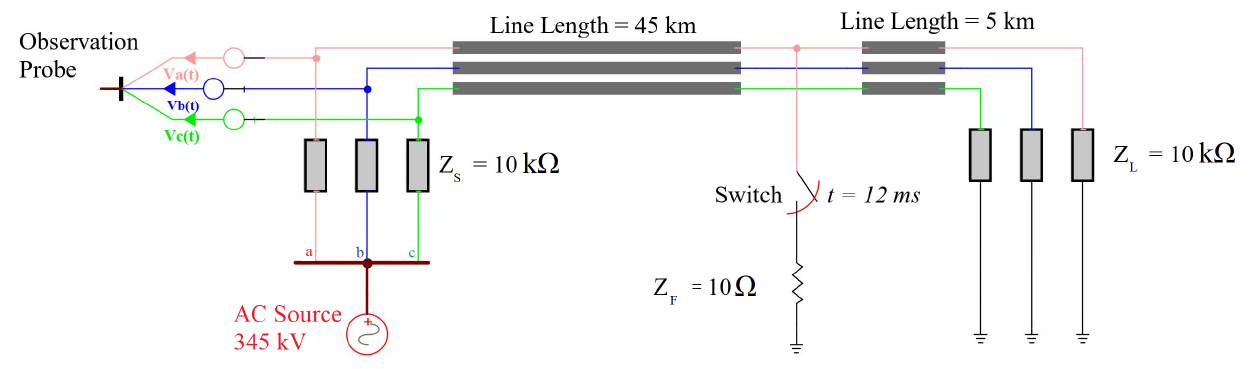
Figure 13. Schematic representation of the system under study, implemented in